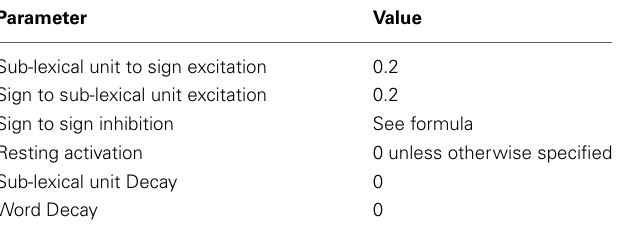
Table 1 | Values Used in All